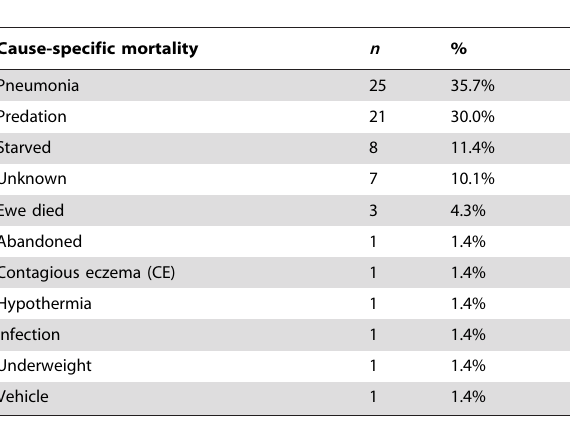
Table 2. Cause-specific mortality of neonate bighorn sheep in the Black Hills, South Dakota, 2010–2012.